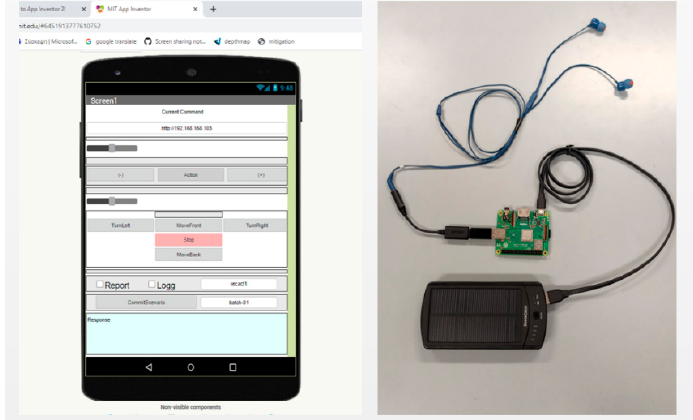
Figure 5. (Left ) The designer view of the MIT App Inventor environment, while creating a robot controlling application variant. ( Right ) The ASUS AI Noise-Cancelling Mic Adapter, along with a small headset, connected to a Raspberry Pi unit, and a power bank, all parts of the operator’s portable voice command equipment.